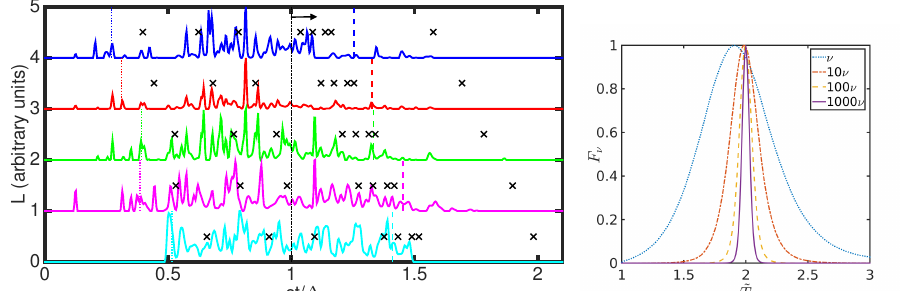
Figure 3. Left: typical prompt emission light curves in the “minijets” model. Degree of anisotropy of minijets’ directions increases from top to bottom. Different light curves (normalized) have been shifted vertically for displaying purposes. Anisotropy shifts the overall light curves to later times. The vertical dotted (dashed) lines for each light curve correspond to the T 90 duration. We include the observed peaks of the GeV light curves (black crosses) for the sample in [173], scaled for each of the simulated light curves. As the level of anisotropy increases, the peaks of the GeV light curves also shift to later times, making most of them consistent with t ≥ ∆ / c , where ∆ is the shell thickness. In the simplest GRB afterglow model, the deceleration time will occur at times t ≥ ∆ / c (see small black arrow) and if the peak of the GeV light curves correspond to the deceleration time, then anisotropic minijets’ directions alleviate the problem of having them at times much less then ∆ / c . From [172]. Right: light curves of a single pulse at different frequencies. The pulse clearly becomes narrower with lower frequencies in some magnetic reconnection models as observed in the prompt emission